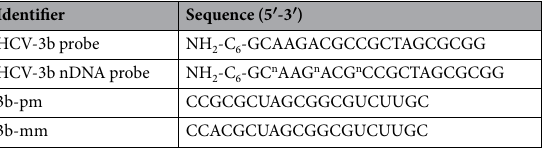
Table 1. Sequences of probes and target RNA molecules. Note: phosphate-methylated nucleotides in the sequence were noted by the superscript